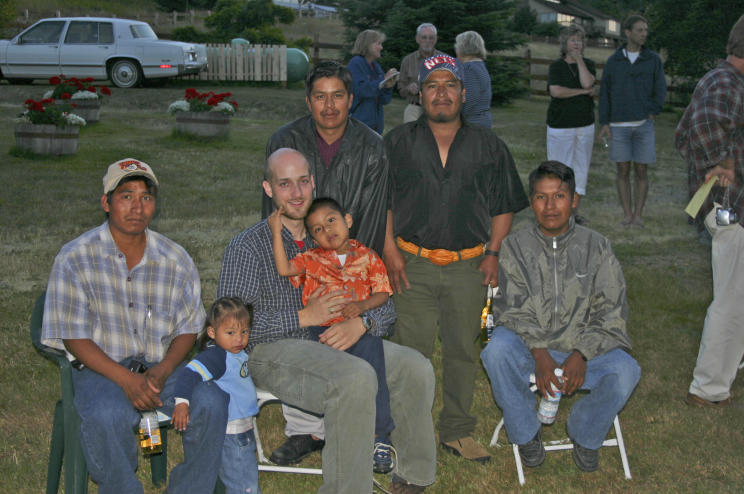
The Anthropologist with Triqui Migrant Workers in Washington StateThe anthropologist with Triqui migrant workers in Washington state.